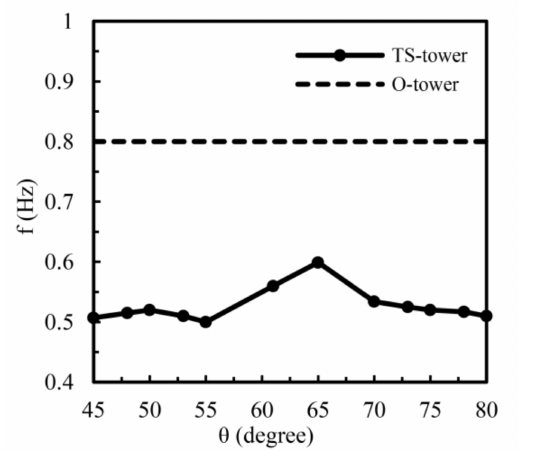
Figure 13. VIV frequency comparison between the O–tower and TS–tower (actual Re =